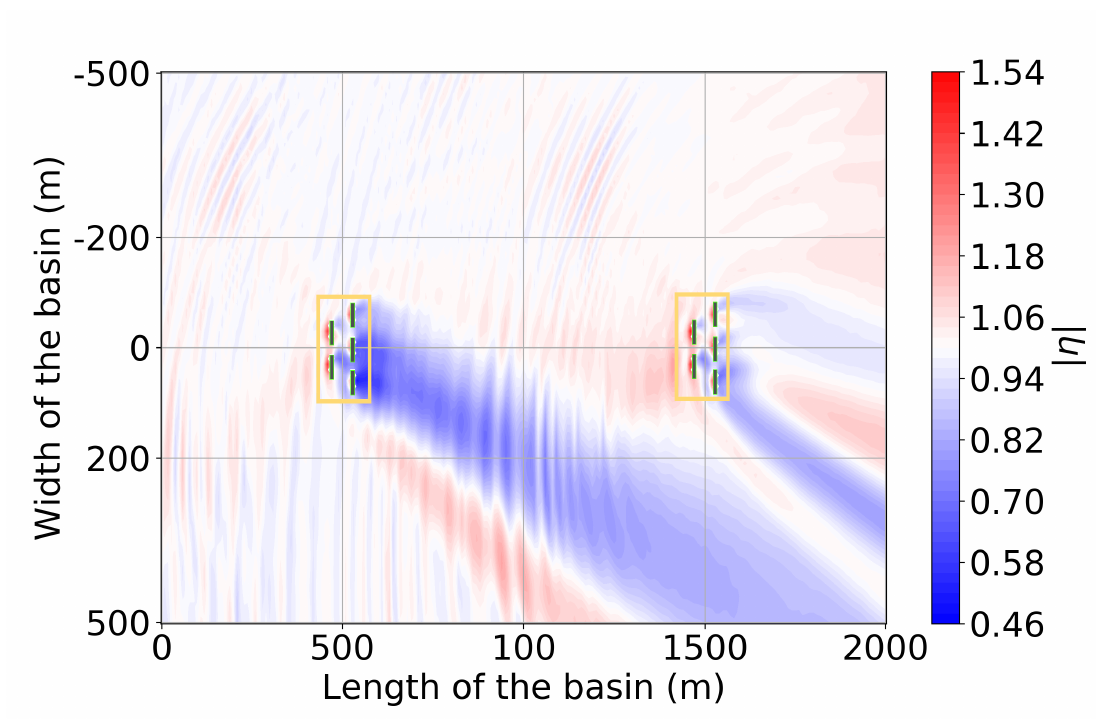
Figure 14. Coupled | η | for H = 2.0 T = 10.0 s and β = − 24 ◦ regular wave for a 10 WEC 2-Array